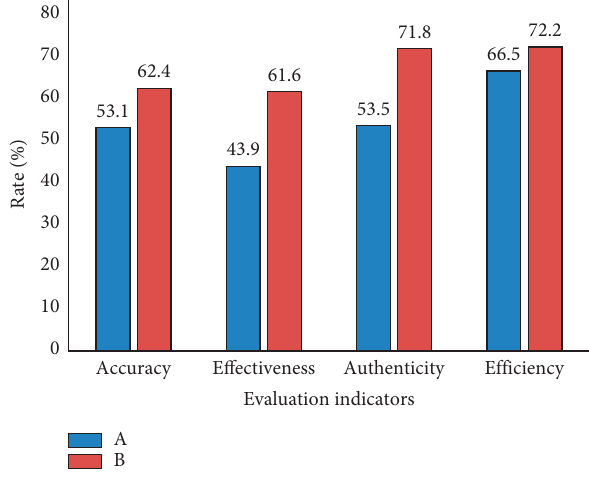
Figure 8: Efciency of sports injury detection in